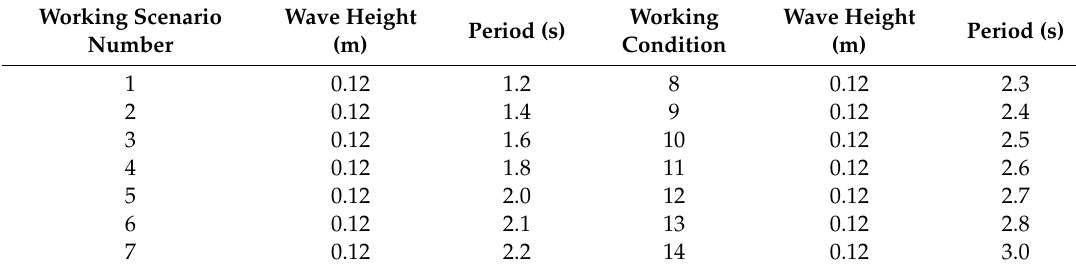
Table 2. The working